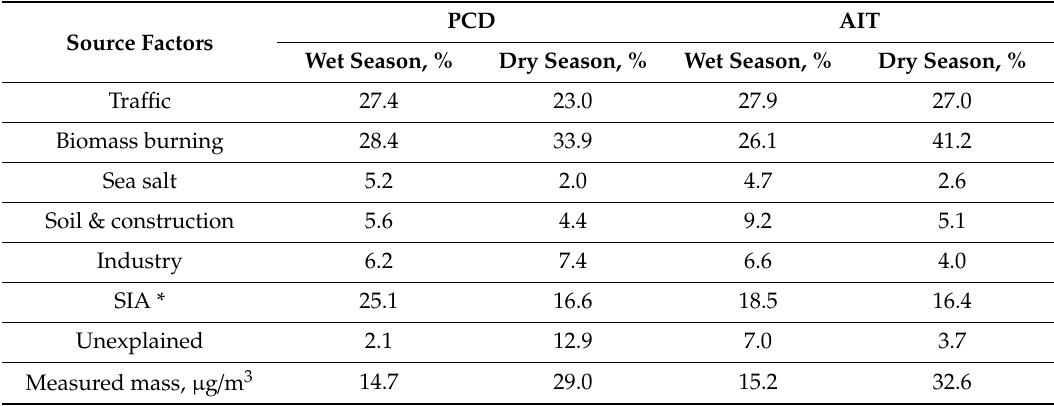
Table 2. Source apportionment results from CMB analysis, percent contributions (%) to PM 2.5 measured at the sites. Source: Tanatat, 2018 (see